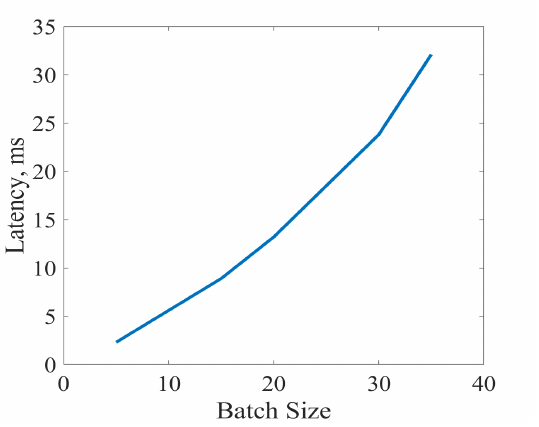
Figure 13. Latency analysis for different batch sizes consistent with Figure 3. Latency is presented in milliseconds and averaged over the test set of the network.